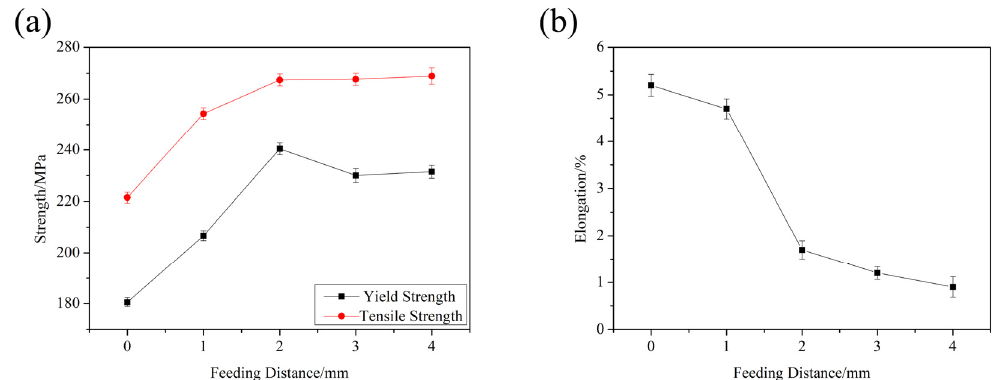
Figure 12. Strength and elongation of the samples with different feeding distances: ( a ) strength; ( b ) elongation.